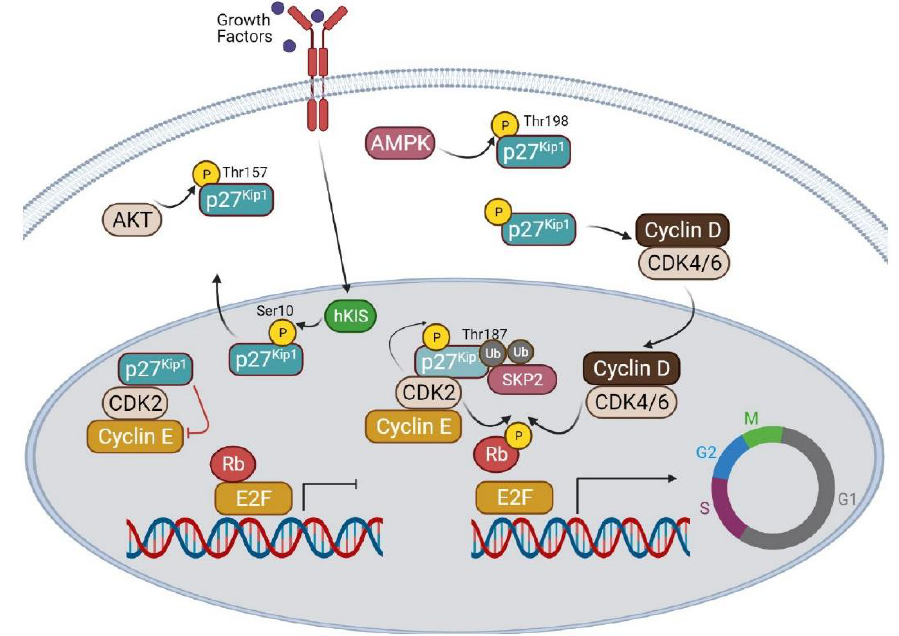
Figure 1. Cell cycle regulation of p27 Kip1 and related signaling pathways. p27 Kip1 can promote cell cycle arrest or proliferation, depending on the cellular location. Nuclear p27 Kip1 will bind cyclin E and CDK2, inhibiting its kinase activity and leaving the retinoblastoma protein (Rb) protein unphosphorylated. In this state, the E2F transcription factor is inhibited from transcribing genes necessary to enter the cell cycle. With proper stimuli and/or growth factors, p27 Kip1 is phosphorylated by CDK2 at Thr187, and is quickly ubiquitinated by SKP for subsequent proteasomal degradation. Without the inhibitor effects of p27 Kip1 , the cyclin E/CDK2 complex can phosphorylate, and inactivate Rb, allowing E2F to transcribe cell cycle genes. p27 Kip1 can also be phosphorylated by hKIS at Ser10, which promotes sequestration to the cytosol. Cytosolic p27 Kip1 can promote cell proliferation by importing cyclin D/CDK4/6 into the nuclei to further target Rb inhibition. Both Akt and AMPK will phosphorylate p27 Kip1 on Thr157 and Thr198, respectively, to stabilize p27 Kip1 in the cytosol and prevent reentry into the nucleus.